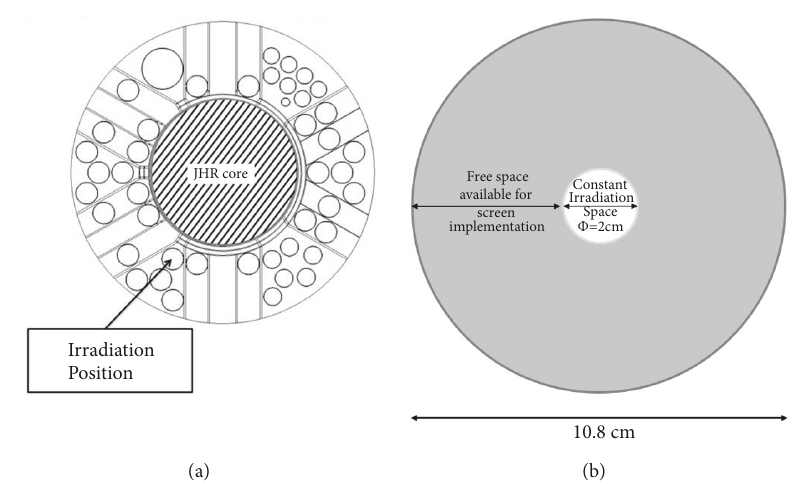
Figure 3: Horizontal cross section of (a) the JHR core as simulated by TRIPOLI-4.8. The arrow points towards the hosting irradiation facility in the reflector which was used for the calculations presented in this work. (b) The considered irradiation device. The available diameter of the JHR location indicated in (a) is 10.8 cm. The screening material is contained in the ring between 2.0 and 10.8 cm, leaving thus a sufficient amount of space for irradiation sample